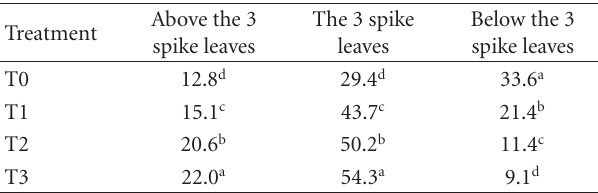
Table 1: Soil moisture accumulation in 0–1.2 m soil profiles before summer maize sowing (mm).